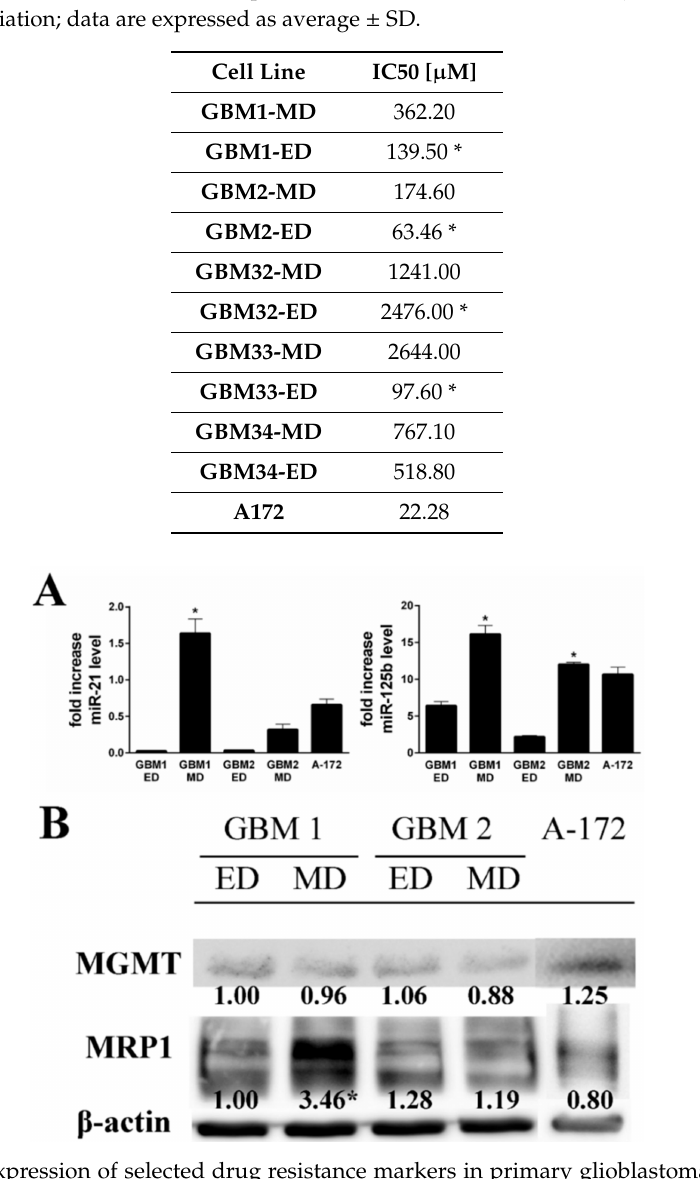
Figure 5. The expression of selected drug resistance markers in primary glioblastoma cells, GBM1 and GBM2, isolated using enzymatic method (ED) and mechanic method (MD) from the GBM of two patients and in stabilized cell line A-172. The expression of miR-21 and miR-125b was determined by RT-PCR ( A ). Data are expressed as fold increase ± SD of averages from two independent experiments. Expression of MRP1 and MGMT proteins were determined by Western blot analysis ( B ). β -actin was used as a loading control. Measurements were performed in three independent experiments. * p < 0.05 ED vs